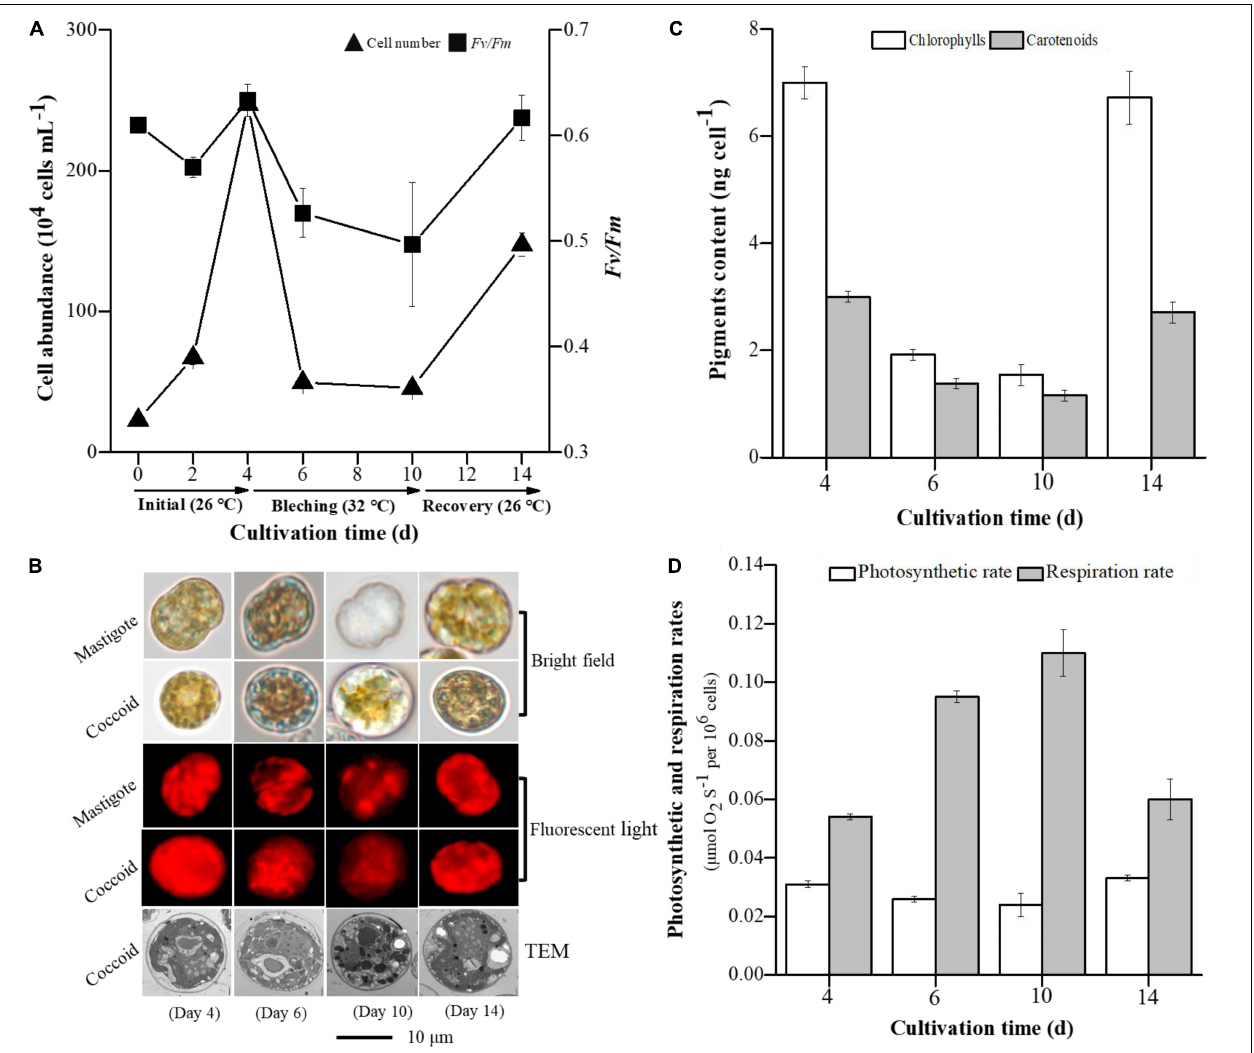
FIGURE 2 | Variations in cell abundance and Fv/Fm (A) , cell morphology (B) , pigment content (C) , photosynthesis and respiration rates (D) in E. voratum SCS01 during the photobleaching and recovery experiment. To monitor the photobleaching and recovery of E. voratum SCS01, the cells were initially cultured under their optimal growth temperature (26 ◦ C, initial period). The cells were exposed to thermal stress (32 ◦ C, bleached period). After incubation under thermal stress, the cells were transferred to their optimal growth temperature again (26 ◦ C, recovery